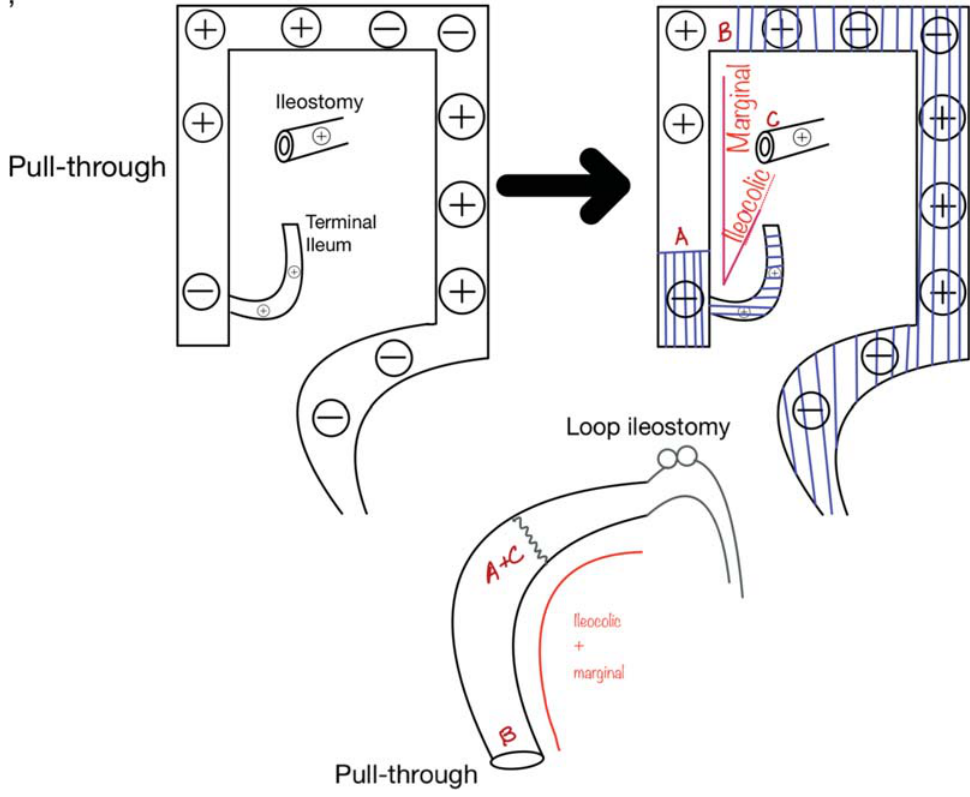
Fig. 4 Cecal resection, extended left colectomy, ileocolic anastomosis, right colonic derotation pull-through of the right colon. The last fi gure shows the fi nal postoperative